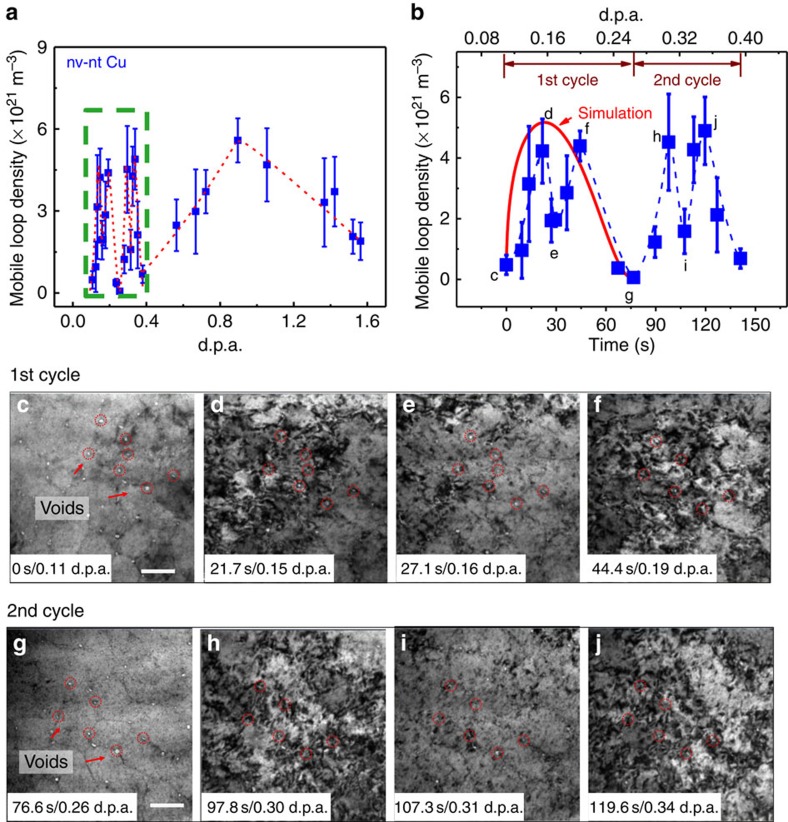
Significant cyclic variation of mobile loop density observed in nv-nt Cu subjected to in situ Kr ion irradiation within 0.4 d.p.a.(a) Statistic studies show cyclic variation of mobile dislocation loop density, with two short cycles during 0.1–0.4 d.p.a. (magnified in b), a 3rd much longer cycle, while little mobile dislocations were observed in cg Cu. In each of the first two cycles, two peaks and an intermediate valley were observed (b). The simulation of the 1st cycle is shown as a red solid line. TEM micrographs in c–f and g–j show cyclic variation of mobile dislocation loop density in two cycles (0.11–0.19 d.p.a.) and (0.26–0.34 d.p.a.). Scale bar, 100 nm in c; scale bar, 100 nm in g. (See Supplementary Movies 2 and 3 for more details on loop density variation for the 1st and 2nd cycle of radiation). The error bars for mobile loop density were determined from the s.d. from the average loop density measured from several locations of the irradiated specimens.